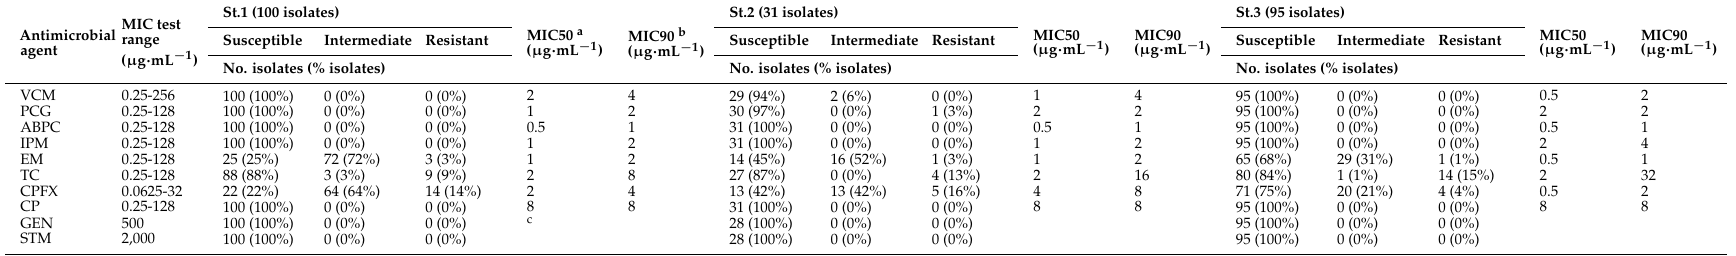
Table 1. Antibiotic susceptibilities of enterococci isolated in Yae River using mEI agar.